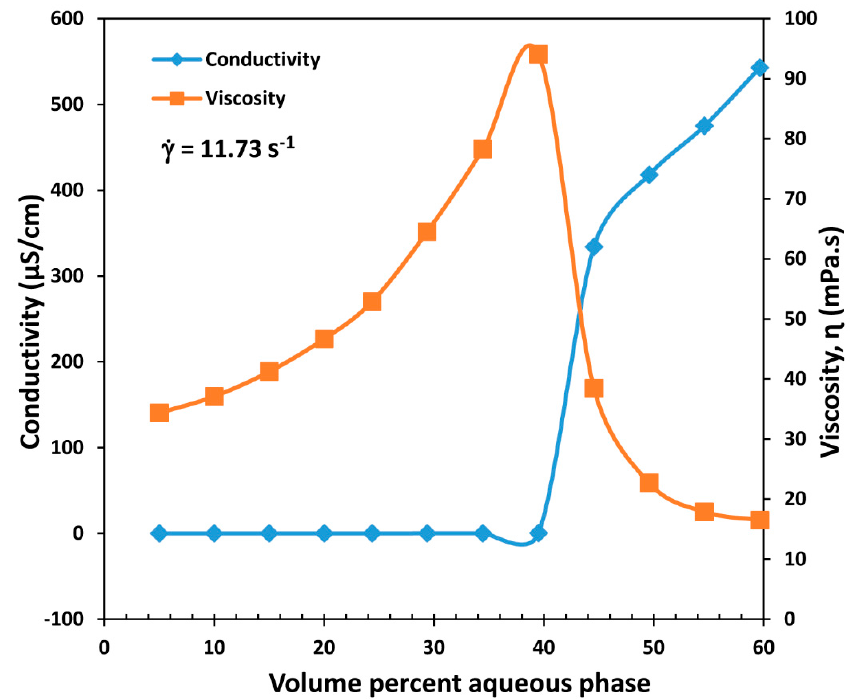
Figure 10. Variations of electrical conductivity and viscosity of emulsion with the increase in aqueous-phase concentration. SNP concentration of aqueous phase is 0.25% wt.